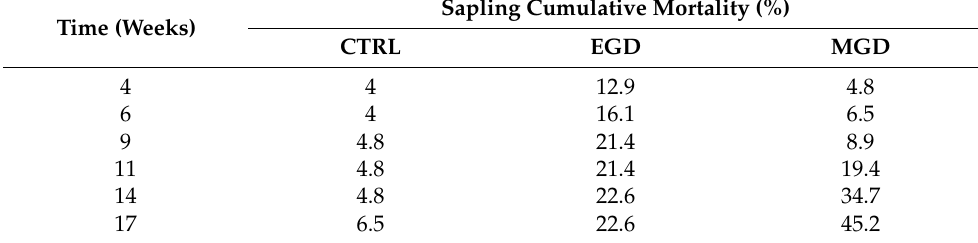
Table 1. Sapling cumulative mortality of Mongolian pine saplings by treatment. CTRL indicates the control. EGD and MGD indicate drought stress treatment in the early- and mid- growing seasons, respectively.